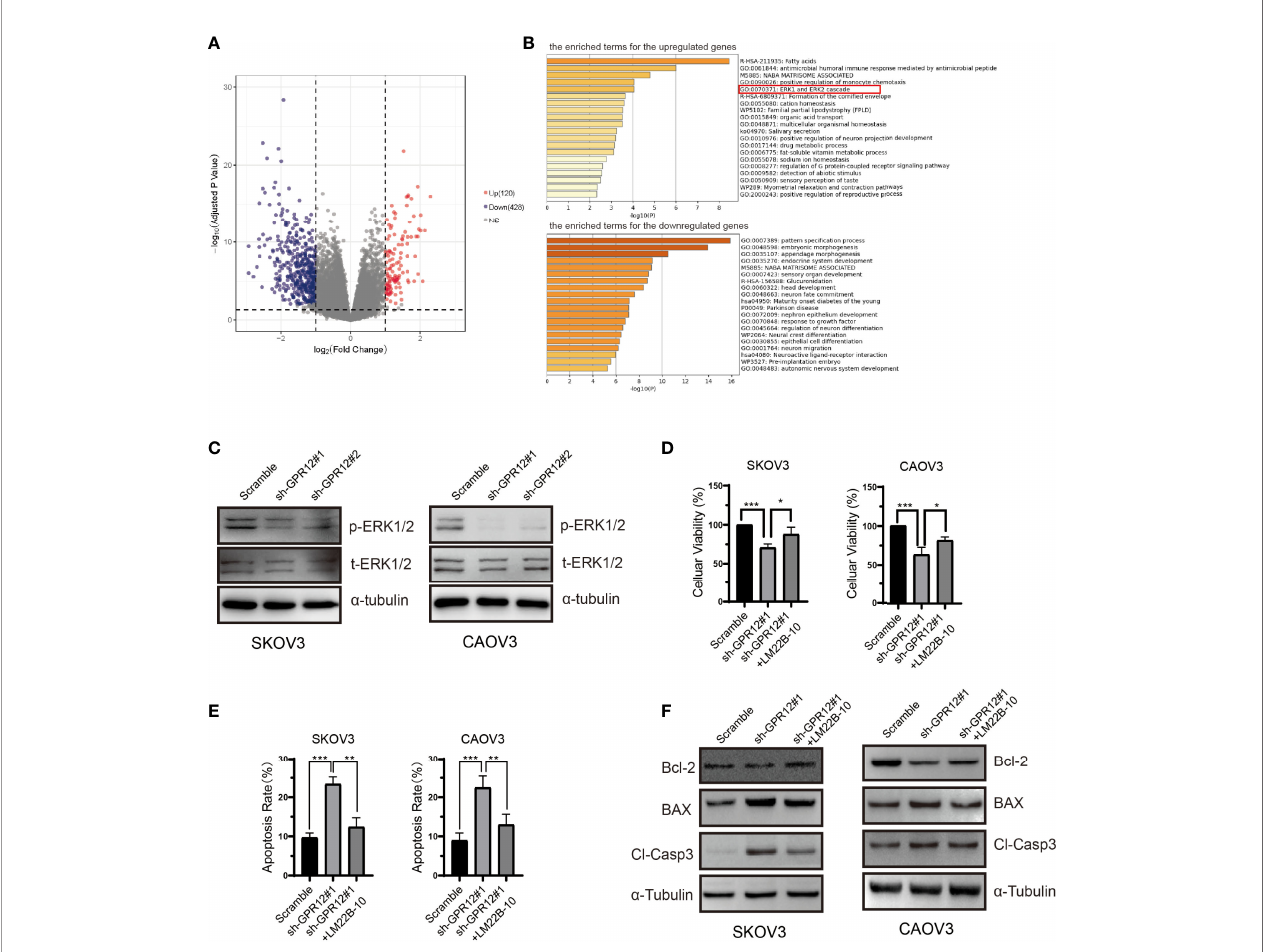
FIGURE 3 | ERK1/2 pathway is involved in the proliferation inhibition induced by GPR12 knockdown in EOC cells. (A) Volcano plot of the upregulated and downregulated DEGs. (B) The enriched terms for the upregulated and downregulated DEGs. (C) Expressions of p-ERK1/2 and t-ERK1/2 in SKOV3 and CAOV3 cells transfected with GPR12-shRNAs were determined with Western blot. (D) Effects of ERK1/2 activator LM22B-10 on the viability of SKOV3 and CAOV3 cells transfected with/without GPR12-shRNAs. (E) Effects of ERK1/2 activator LM22B-10 on the apoptosis of SKOV3 and CAOV3 cells transfected with/without GPR12-shRNAs. (F) The protein expressions of Bcl-2, BAX, and cleaved caspase 3 in SKOV3 and CAOV3 cells after GPR12 knockdown with/without the presence of